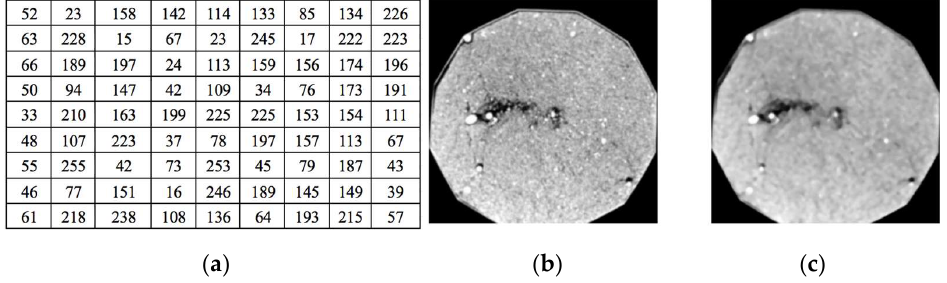
Figure 9. CT images of the fault of soil roots: ( a ) 9 × 9 filtering template of the median filter; ( b ) original image; ( c ) filtered image.